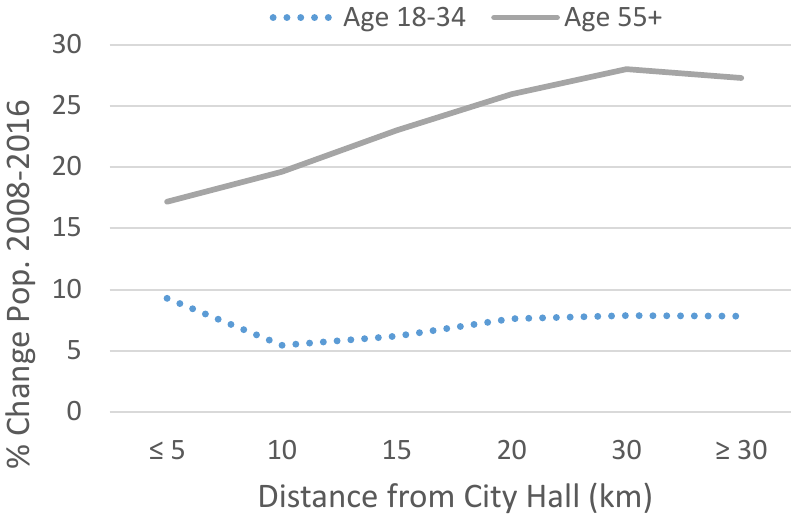
Figure 1. Percent change in younger and older adult populations in the U.S. between 2008 and 2016 by distance from city hall. Source: authors’ analysis of U.S. Census American Community Survey (ACS) data.